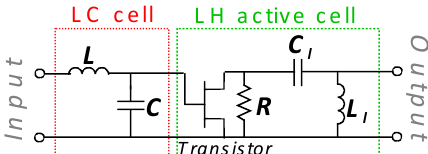
Figure 3: LC-circuit compensated with LH active